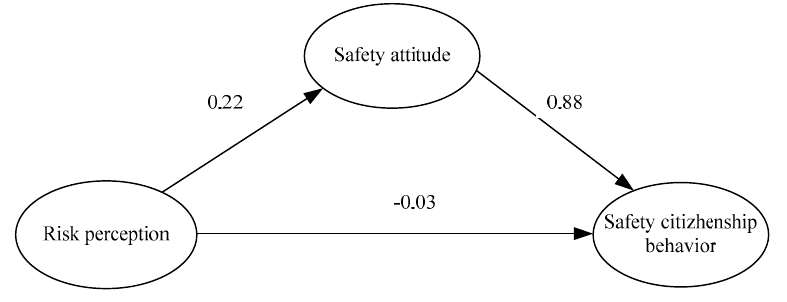
Figure 3. The standardized results of model M2. Table 9. The fitting result of model M2.